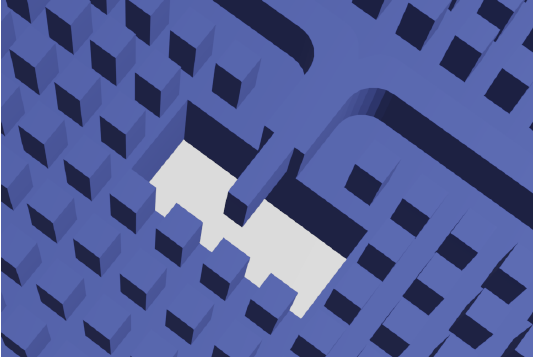
Figure 7. WR28 to RGW transition.